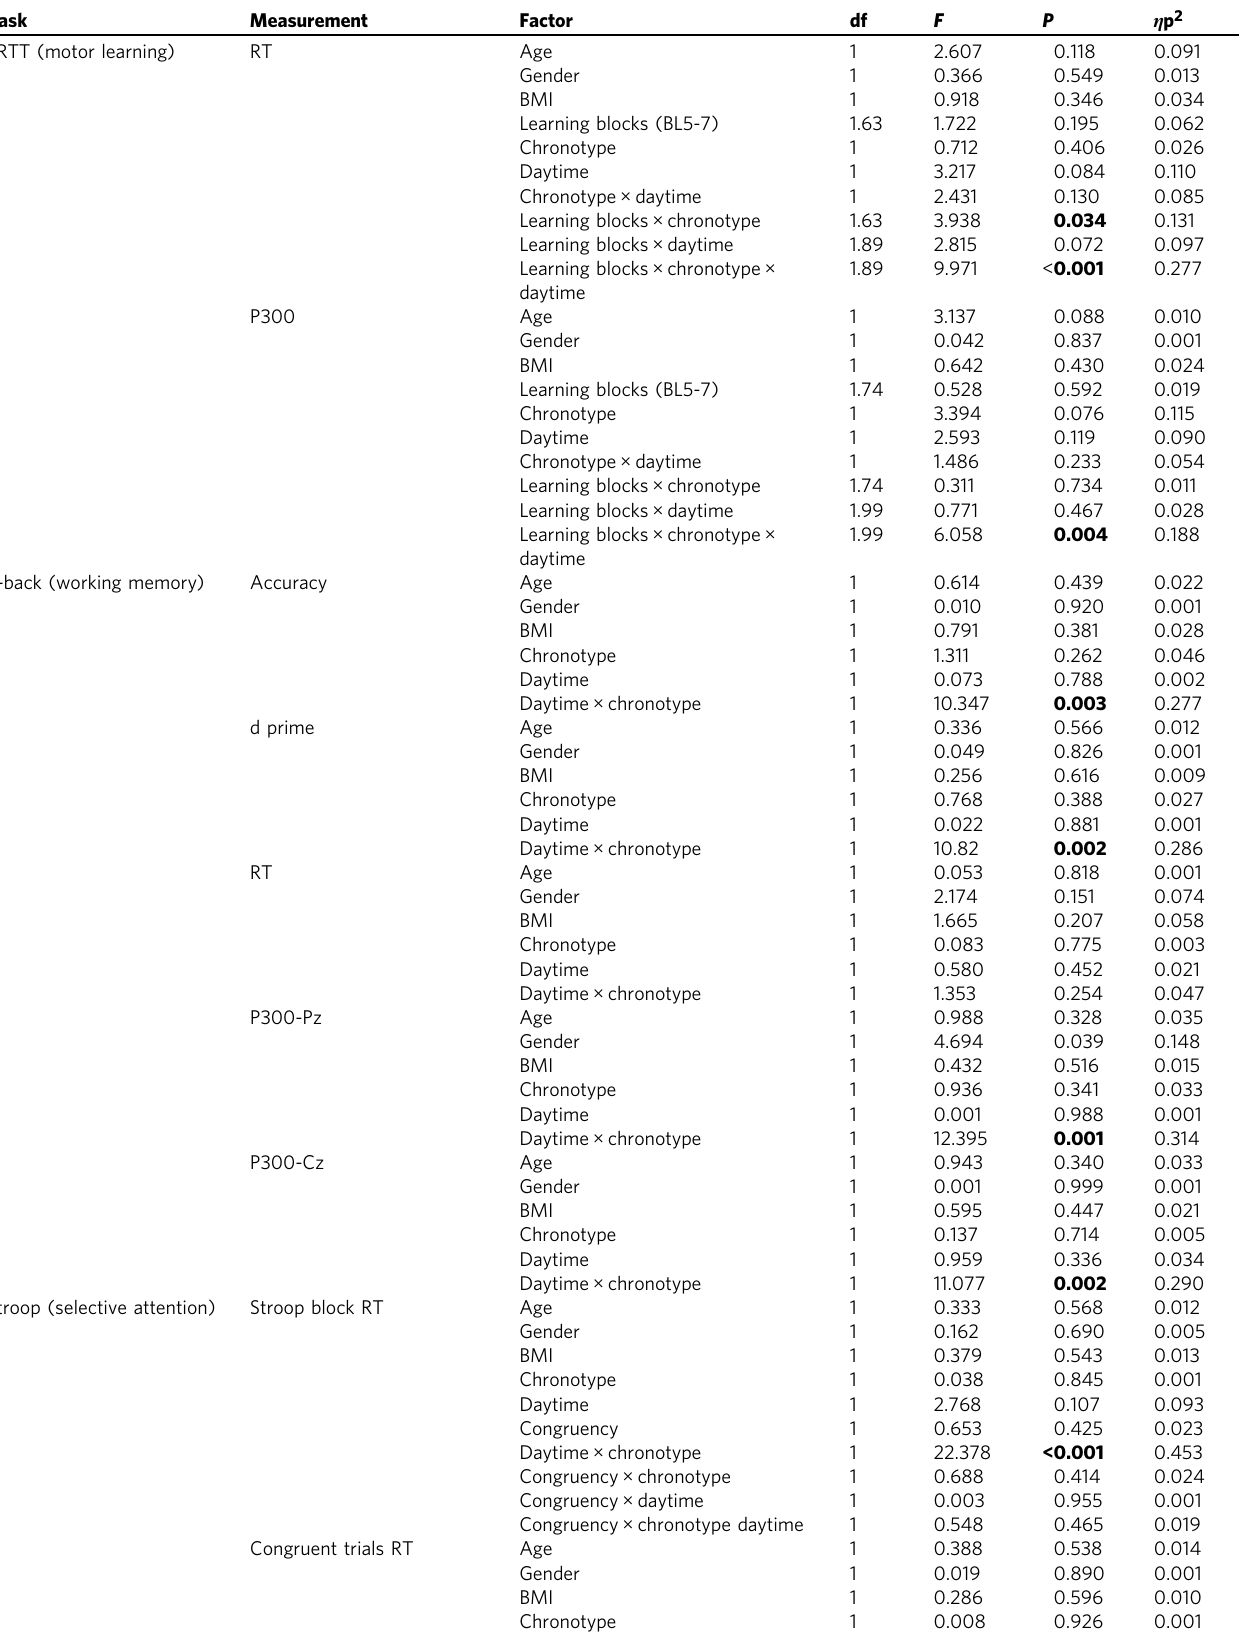
Table 3 Results of mixed factorial ANOVAs for cognitive task performance and respective ERP components.